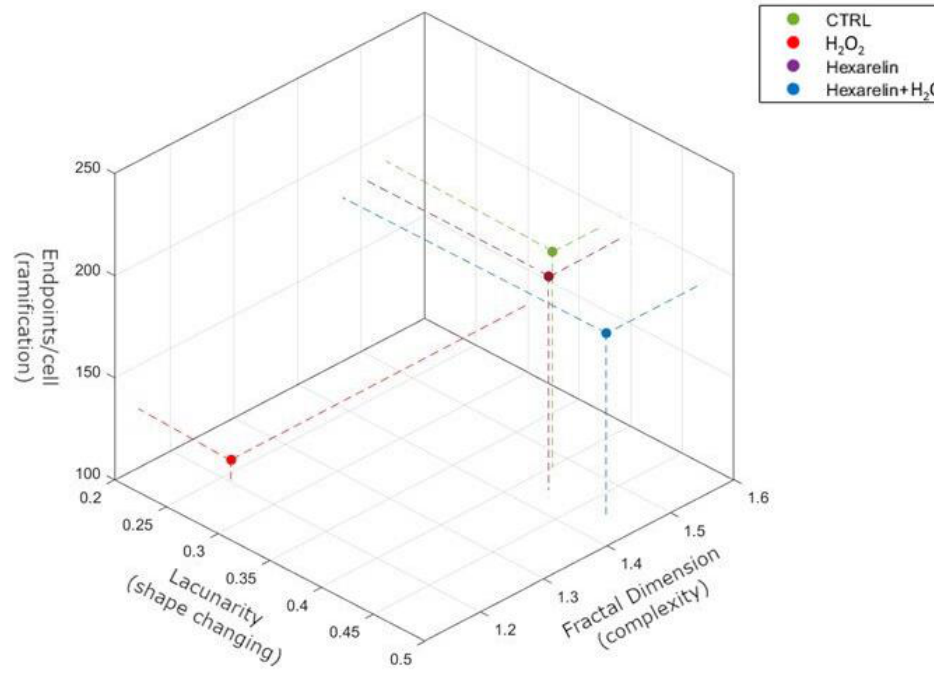
Figure 7. Summary representation of Skeleton and FracLac analysis by 3D scatter plot. The figure summarizes the rela- tionship between ramifications (endpoints/cell), shape changing (lacunarity) and complexity (fractal dimension). Pear- son’s correlation demonstrates that fractal dimension significantly correlates with endpoints/cell (r = 0.9806, p = 0.0098) but not with lacunarity (r = 0.8134, p = 0.0981). Endpoints/cell directly correlates with both fractal dimension (r = 0.9806, p = 0.0098) and lacunarity (r = 0.7765, p = 0.0038).